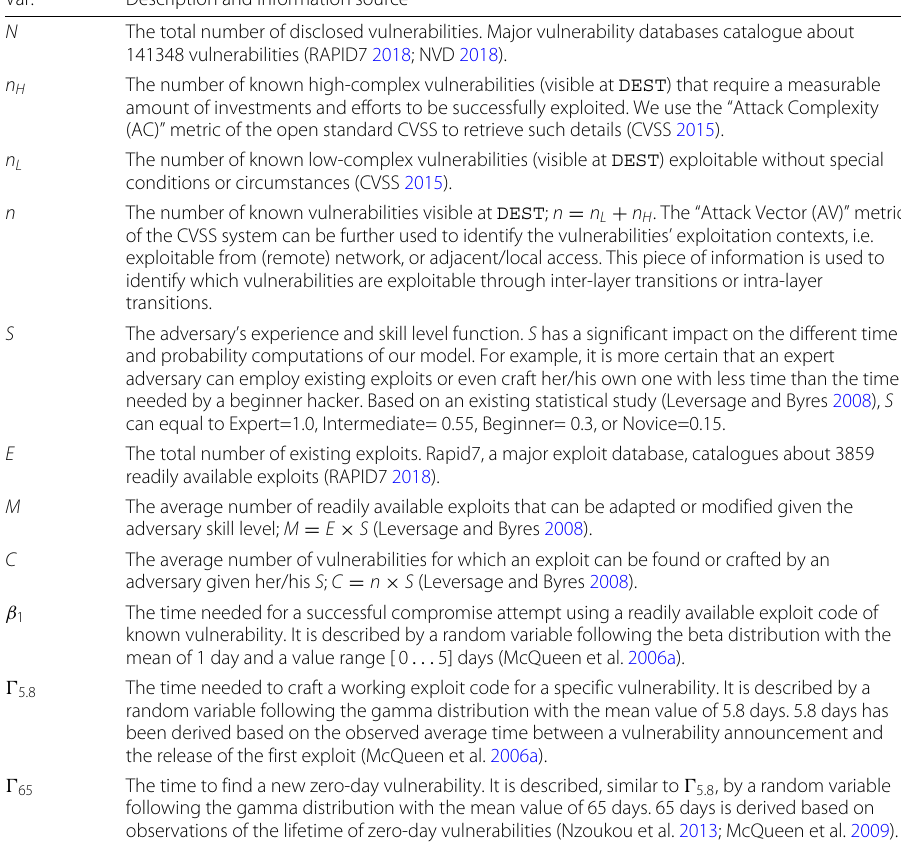
Table 1 A list of our TTC model inputs